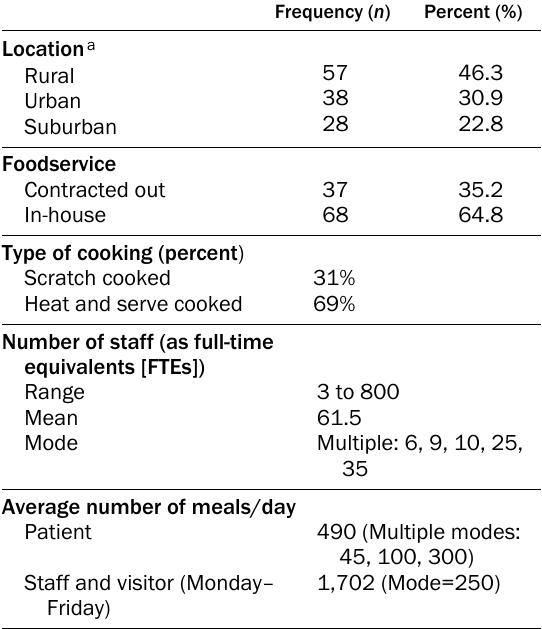
Table 1. Hospital Characteristics